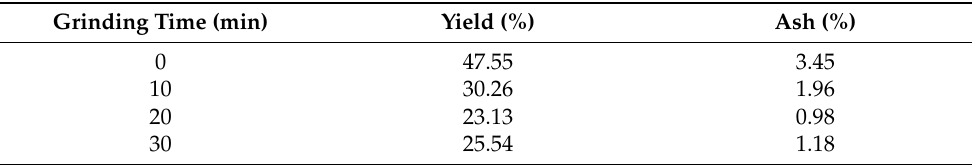
Table 3. Ash content and yield of − 1.3 g/cm 3 density grade particles. Grinding Time